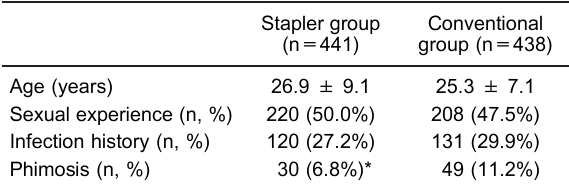
Table 1. Characteristics of patients who underwent stapler or conventional